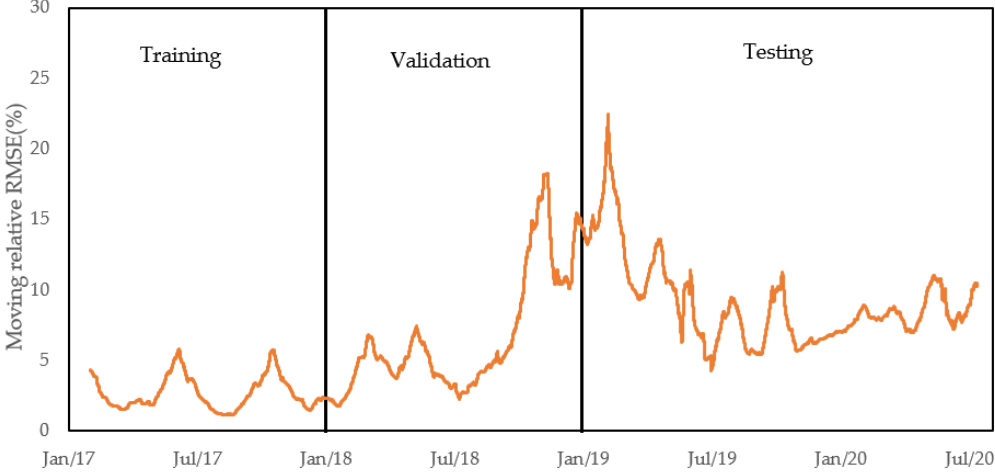
Figure 7. 30-day moving relative RMSE for the hybrid model with one year of training period.